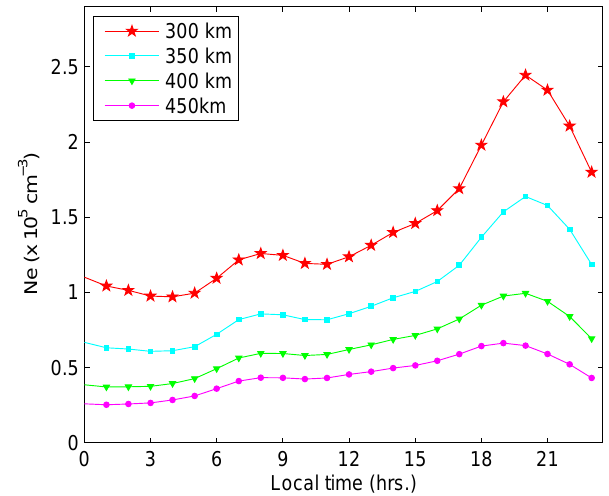
Fig. 1. Local time variation of N max at various latitudes during July 2008, obtained from F3/C measurements corresponding to 135 ◦ E longitude.